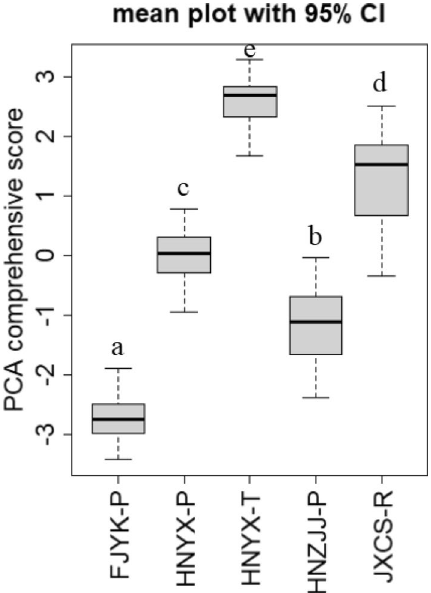
Figure 4. Mean comprehensive score of PCA plot with 95% CI. Different letters (a, b, c, d, e) mean significant difference at 0.05